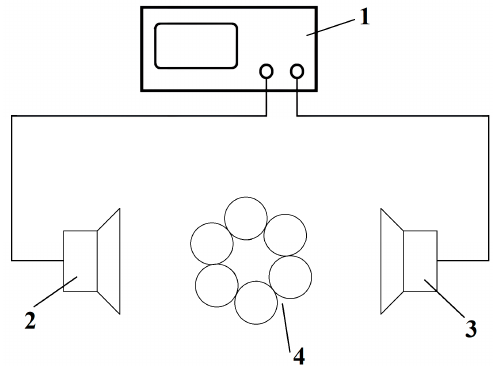
Figure 8. The microwave measurement system: 1—network analyzer; 2, 3—horn antennas; 4—six identical lamps of the standard size T8 connected in series.